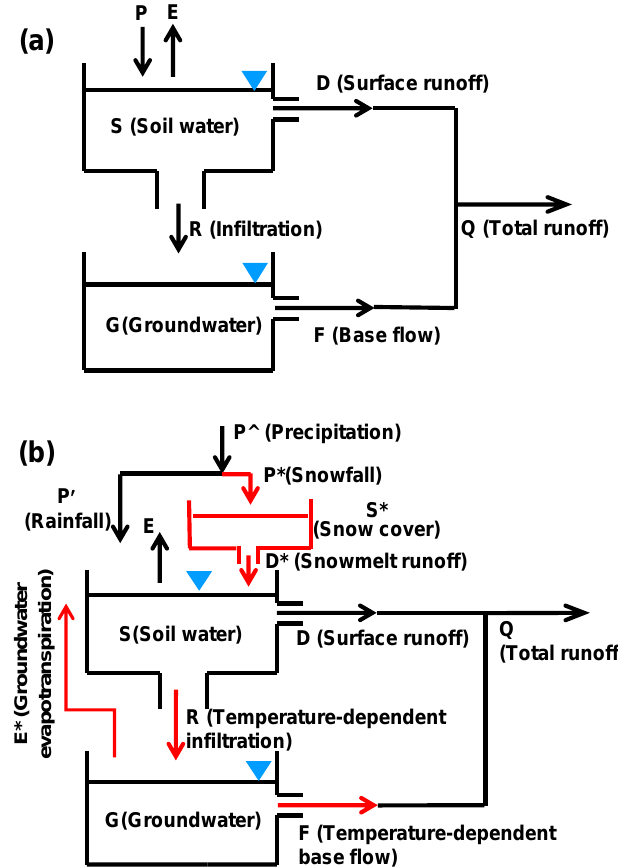
Figure 5. Outlines of models: ( a ) the ABCD model; ( b ) the Modified ABCD Model for Cold Regions (ABCD-CR) model.